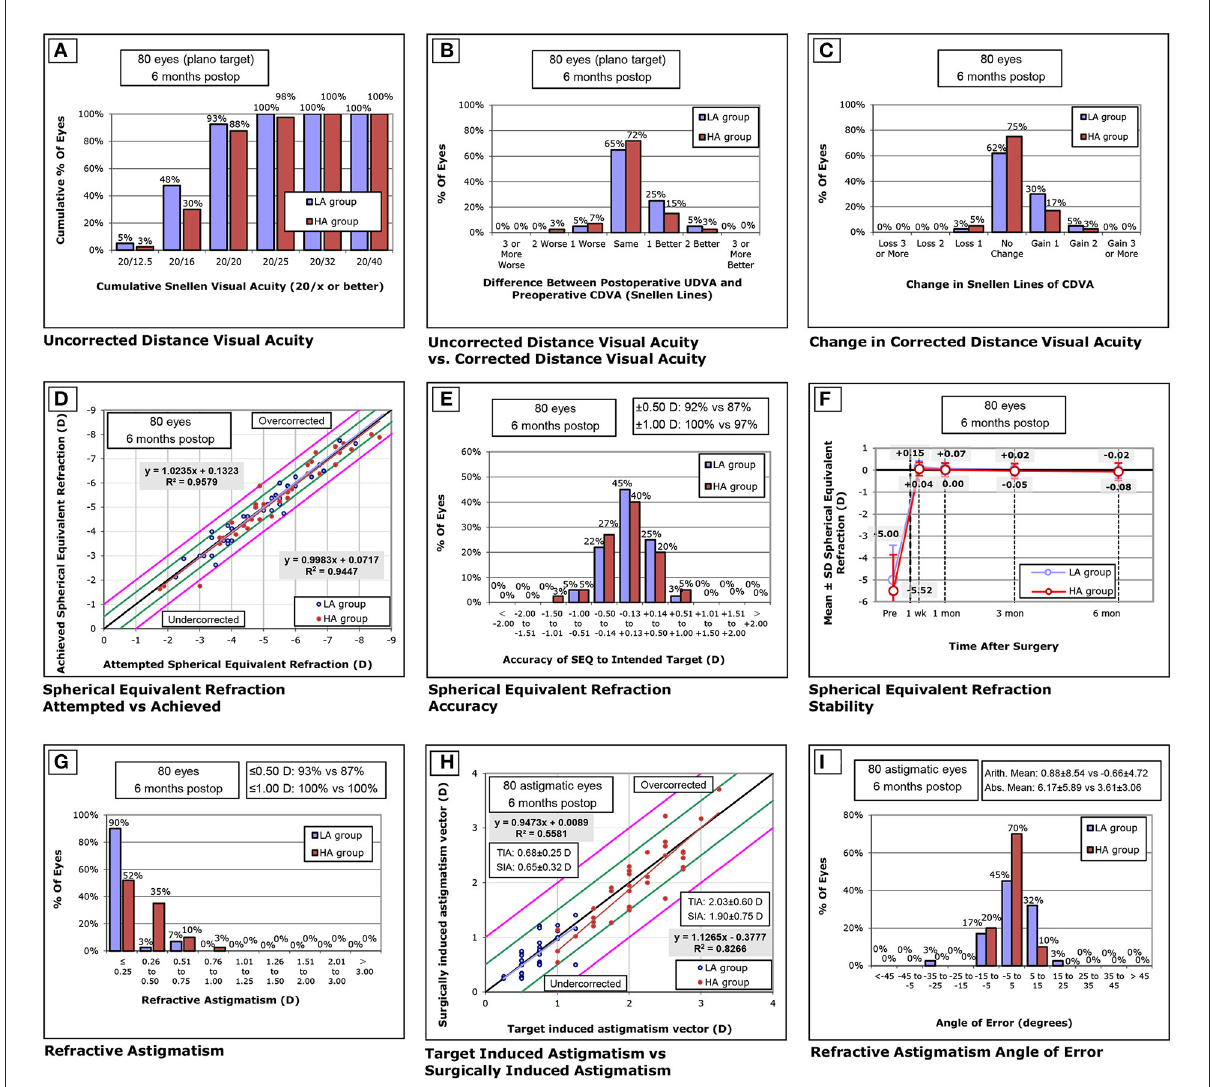
FIGURE1 Visual outcomes at 6 months after SMILE. (A) uncorrected distance visual acuity (UDVA) outcomes. (B) postoperative UDVA and preoperative corrected distance visual acuity (CDVA). (C) change in CDVA. (D) distribution of achieved spherical equivalent outcomes. (E) spherical equivalent refractive accuracy. (F) stability of spherical equivalent refraction. (G) refractive astigmatism. (H) target induced vs. surgically induced astigmatism vectors, and (I) refractive astigmatism angle of error distribution at 6 months postoperatively. D,